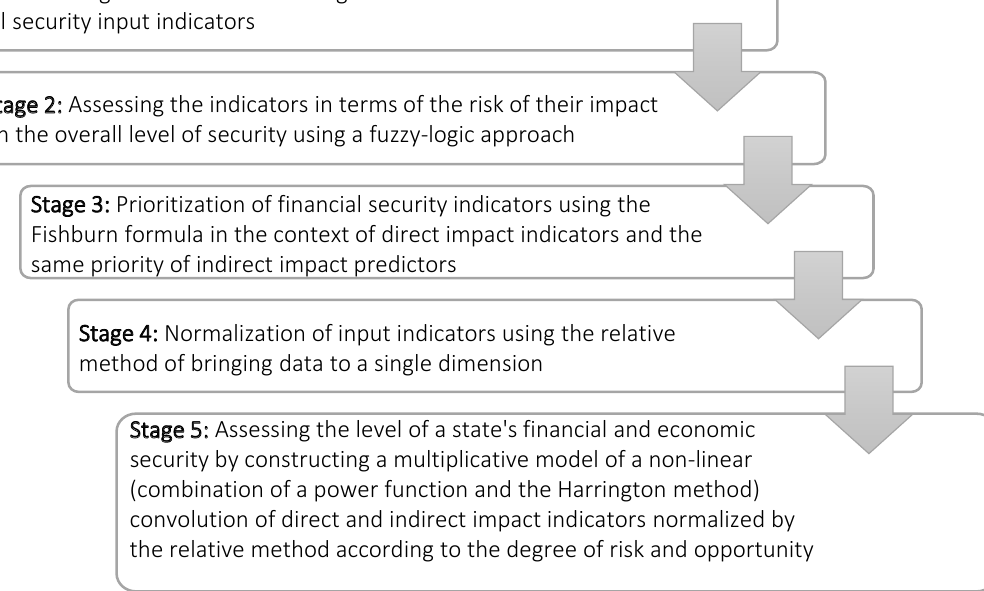
Stage 1: Selecting indicators and creating the information base of finacial security input